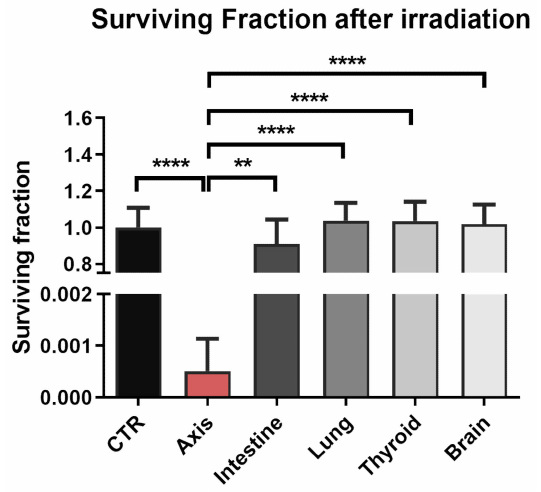
Figure 4. Effect of VMAT SBRT irradiation on survival of healthy prostate cells positioned in the prostate and peripheral organs. Survival was measured using clonogenic assay. The surviving fraction of these cells compared to sham-irradiated cells was measured for each location. Data are shown as means ± SD of three independent experiments, normalised to the mean of the sham-irradiated cells (CTR). **— p < 0.01, ****— p < 0.0001, based on one-way ANOVA with Tukey’s post-hoc